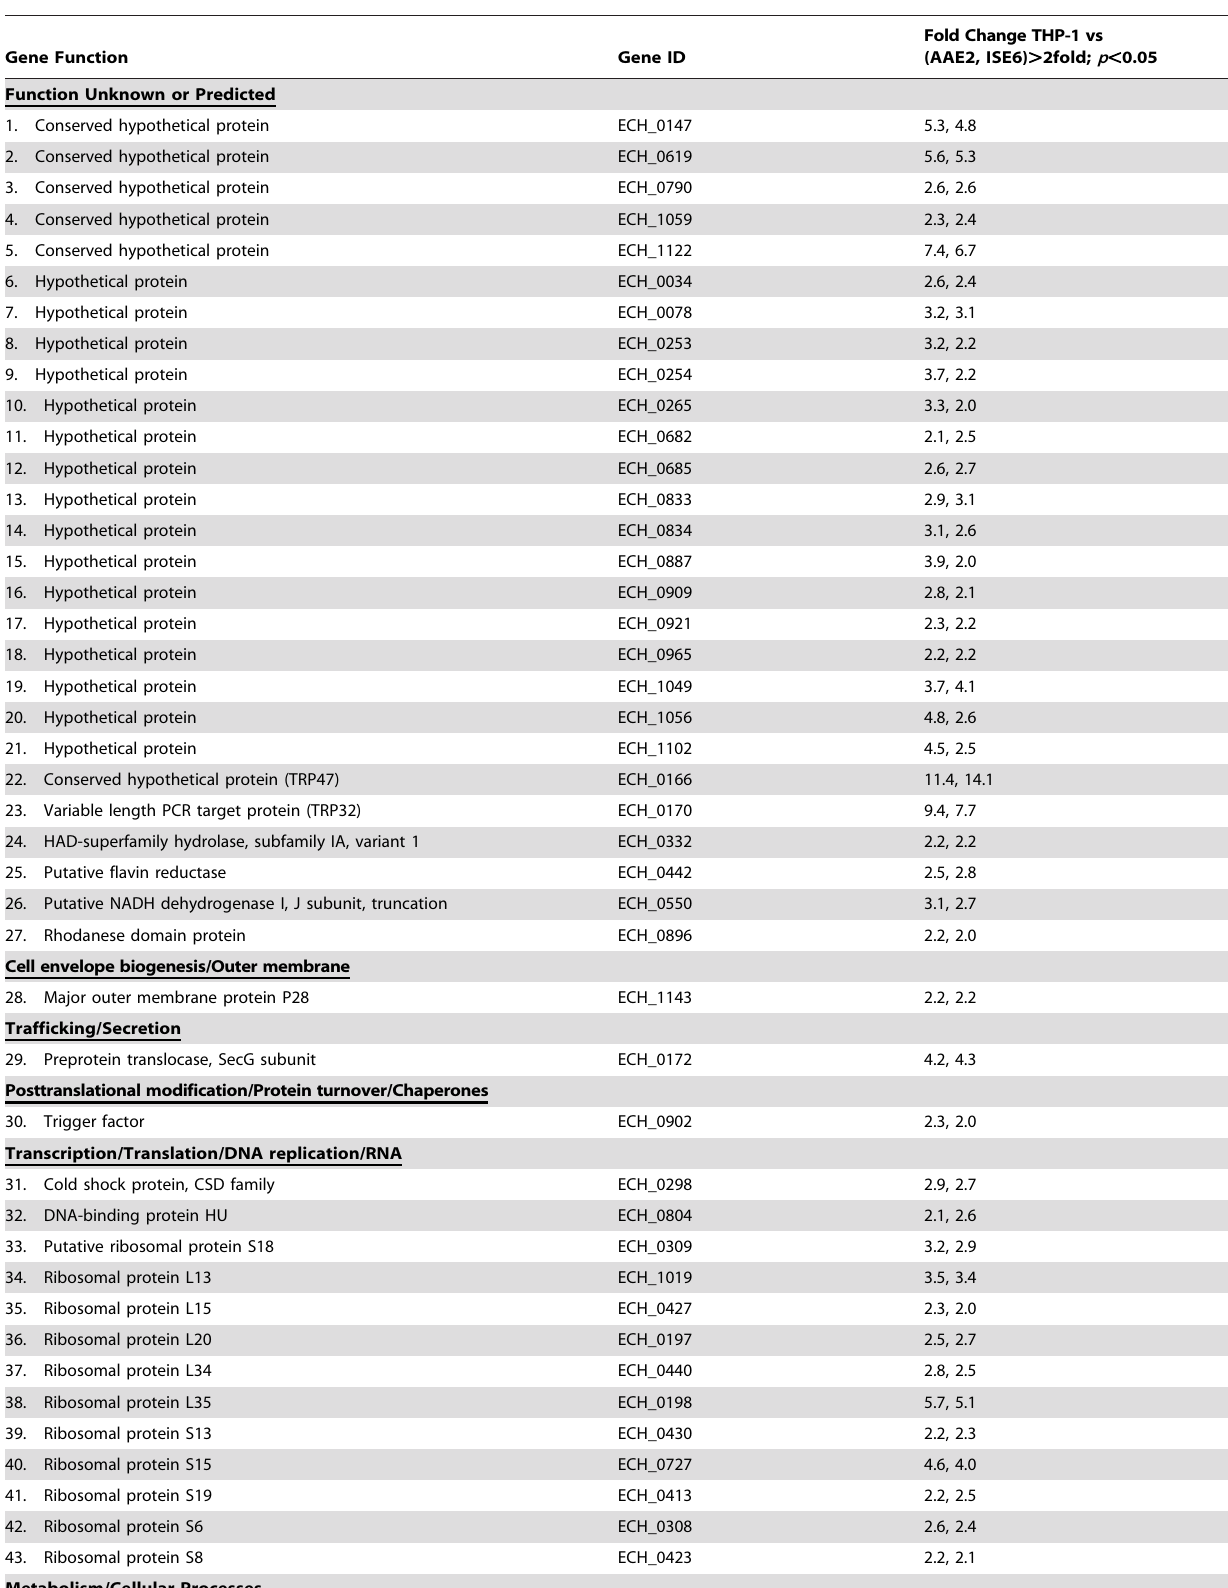
Table 1. E. chaffeensis genes upregulated in THP-1 cells compared to AAE2 and ISE6 cells.